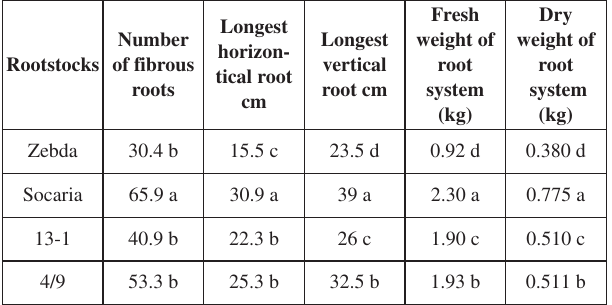
In Columns, the numbers which are followed by different characters means that there are significant differences